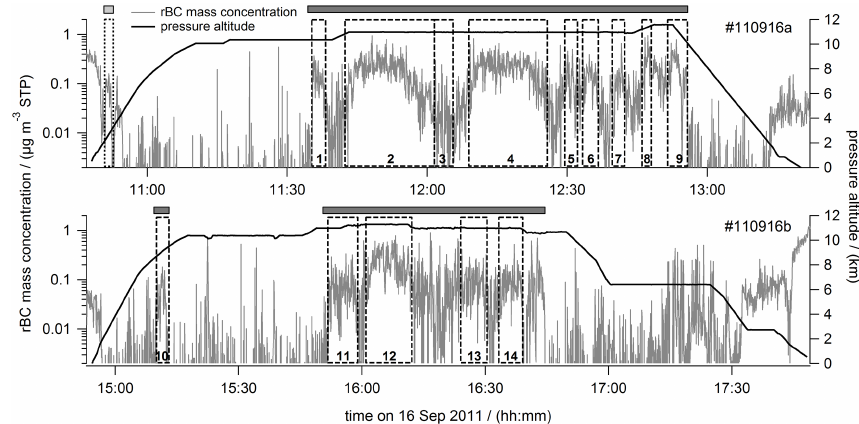
Figure 2. Time series of the rBC mass concentration (STP) in the SP2 size range (grey lines) for flight #110916a (up) and flight #110916b (bottom). The flight altitude is shown in black lines. The grey bars represent the sequences of continuous forest-fire aerosol layer sampling, i.e., the flight time in the area where the Pagami Creek fire aerosol layer was situated. The dashed boxes represent sequences, which are used for detailed analysis. These 14 sequences were chosen to represent parts of the aerosol layer with high and low loads, without interference of other aerosol sources such as aircraft emissions. The region between segment 12 and 13 was excluded because here the mixture of aircraft exhausts and contrails with the Pagami Creek fire plume was